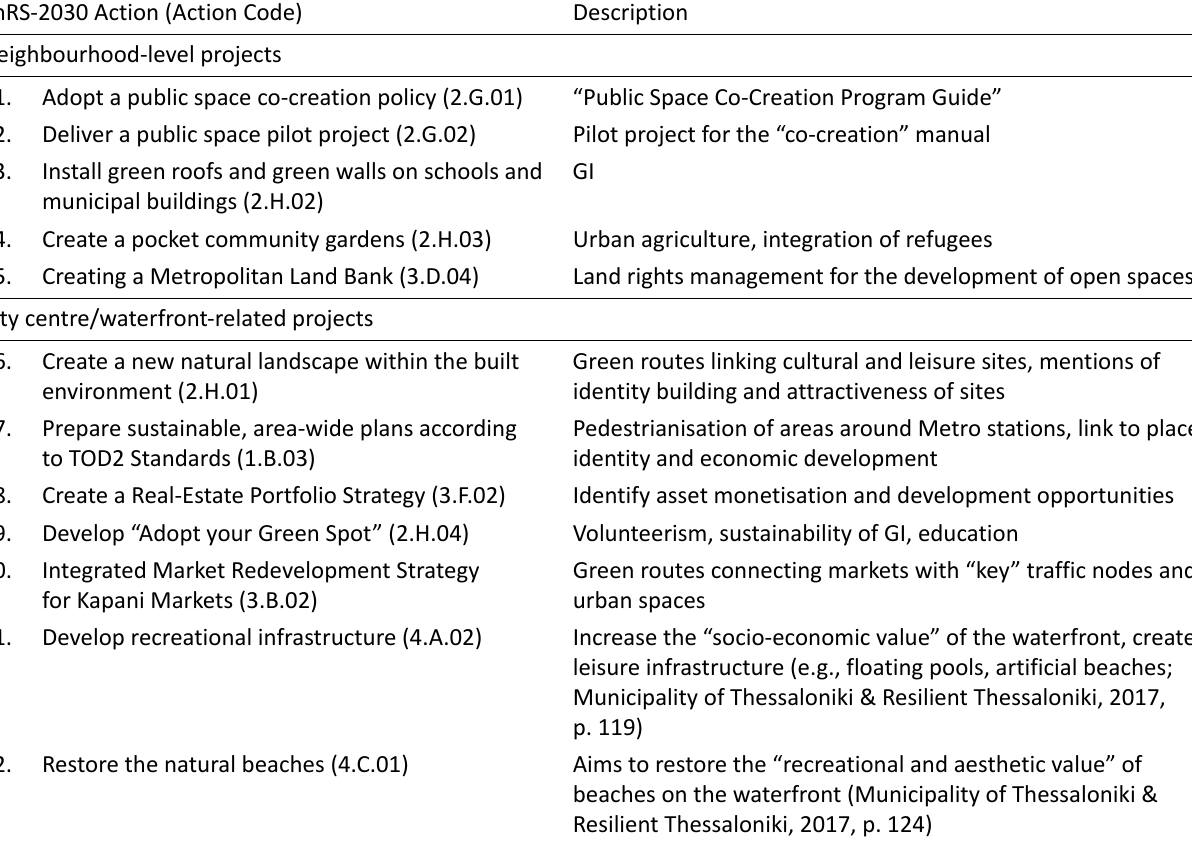
Table 3. Actions related to (green) public spaces in the ThRS‐2030 policy